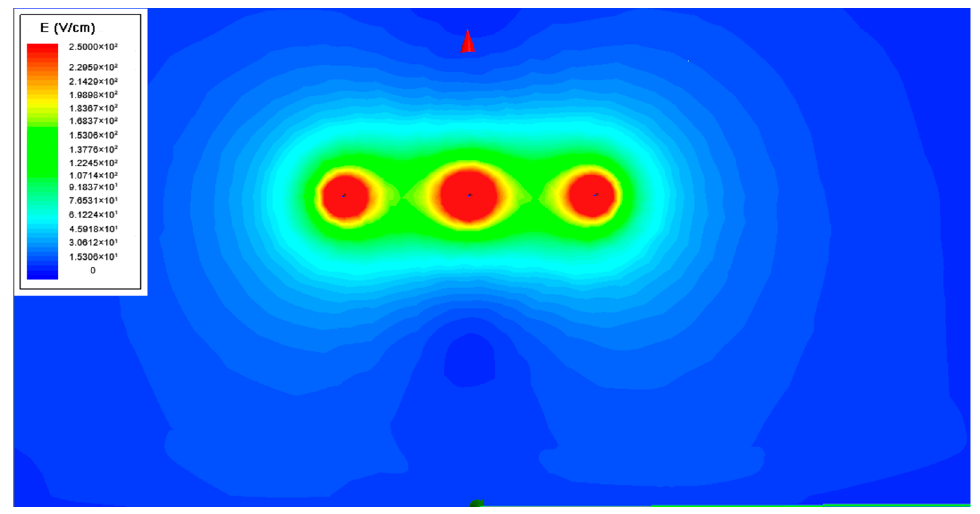
Figure 5. Distribution of E-field below the 10 kV three-phase overhead line.